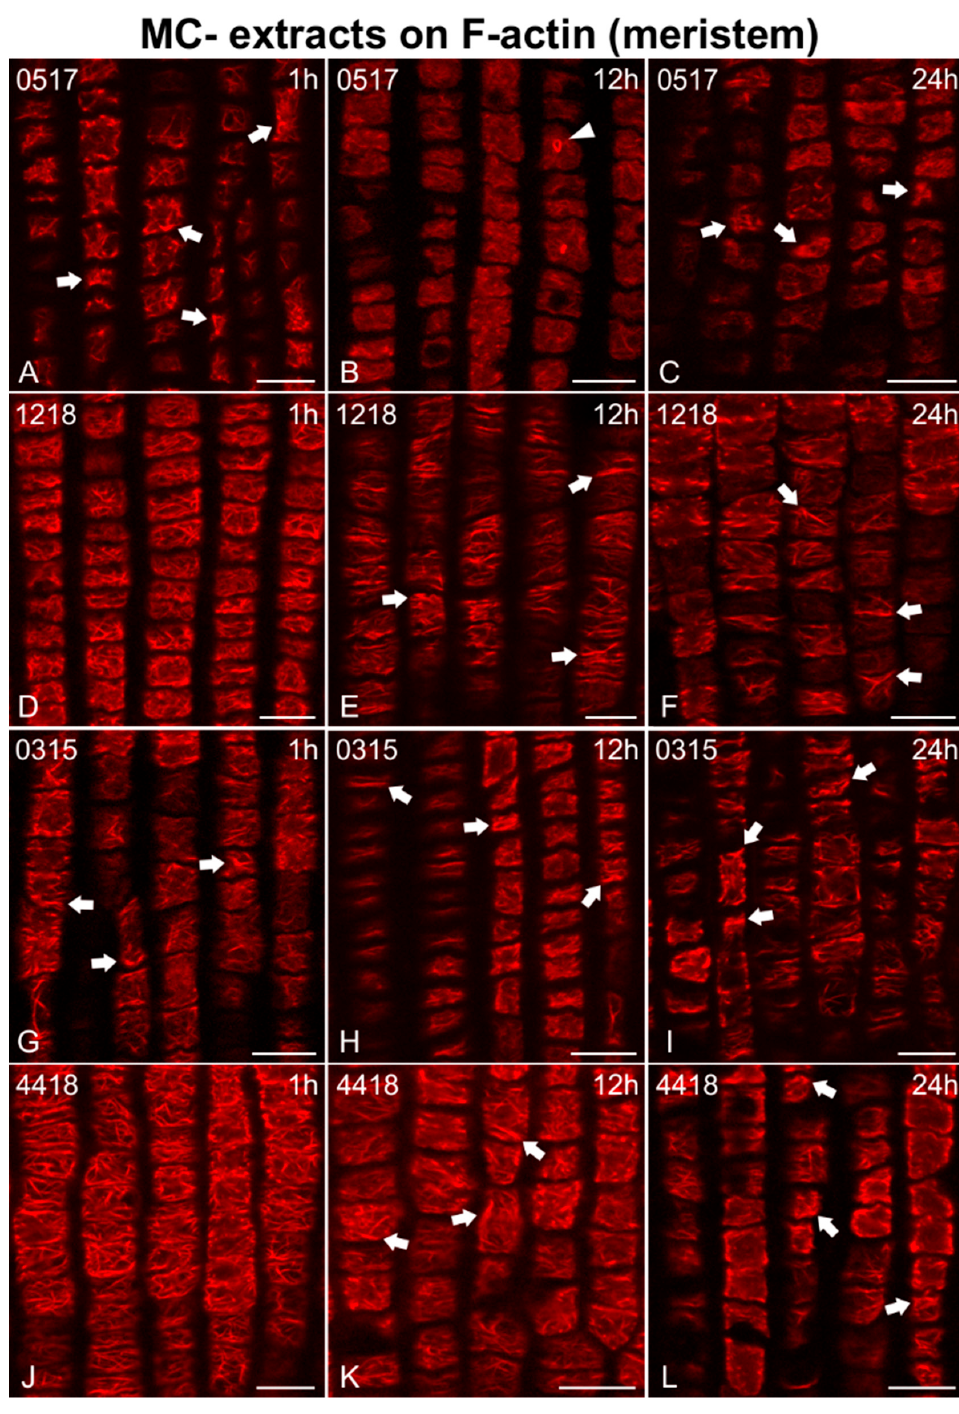
Figure 6. Single cortical CLSM sections of Oryza sativa root protodermal cells stained for F-actin, after treatment with MC − extracts from various non-MC-producing strains: Phormidium sp. TAU-MAC 0517 ( A – C ), Scytonema sp. TAU-MAC 1218 ( D – F ), Nostoc oryzae TAU-MAC 0315 ( G – I ), and Lyngbya sp. TAU-MAC 4418 ( J – L ). Root tips in all images point towards the bottom of the page. After 1 h of exposure to the extracts, affected cells exhibited bundled (arrows in A , G ) and branched cortical actin filaments ( D , J ). After 12 h, the F-actin network deteriorated ( B , E , H ) and bundles could be observed (arrows in E , H , K ), with occasional actin rings (arrowhead in B ). After 24 h, actin filaments were scarce and bundled (arrows in F , I , L ) or weak, with actin aggregates being detected (arrows in C ). Scale bars: 10 µ